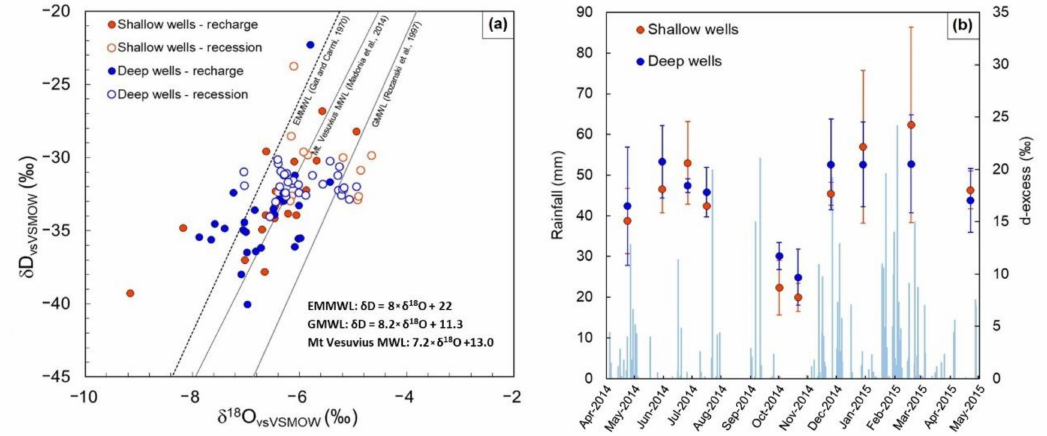
Figure 8. ( a ) δ 18 O vs. δ D diagram in shallow and deep wells during the recharge (closed circles) and the depletion (open circles) hydrological phases in shallow (red circles) and deep (blue circles) wells. ( b ) Monthly variations of d-excess in shallow (red circles) and deep (blue circles) wells; the circles represent the mean values with 1 sigma standard deviation. In the plot, the daily rainfall amounts (light blue bars) are